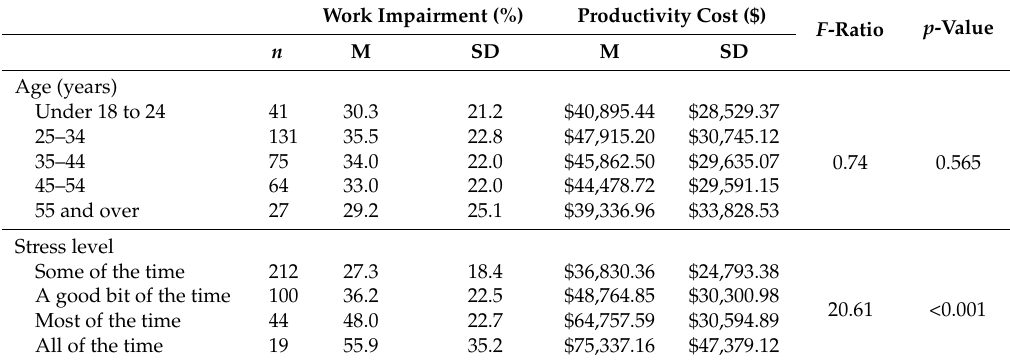
Table 3. Group differences based on work impairment percentage and annual productivity